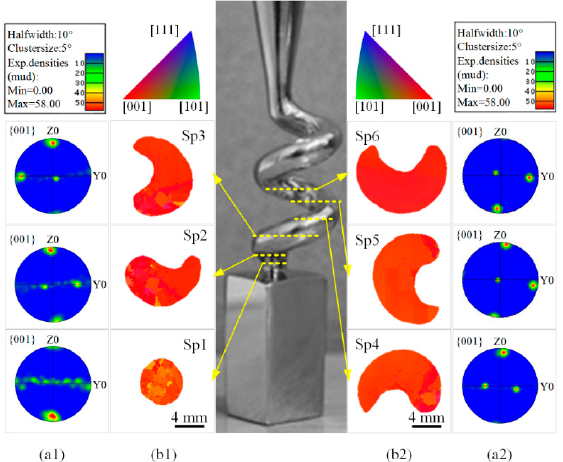
Figure 7. EBSD orientation imaging microscopy (OIM) of different cross sections in spiral part ( a1 ) and ( a2 ): pole figures (PF); ( b1 ) and ( b2 ): inverse pole figures (IPF); structure of spiral part: d s = 12 mm, h s = 14 mm, θ = 20° and d w = 5 mm.